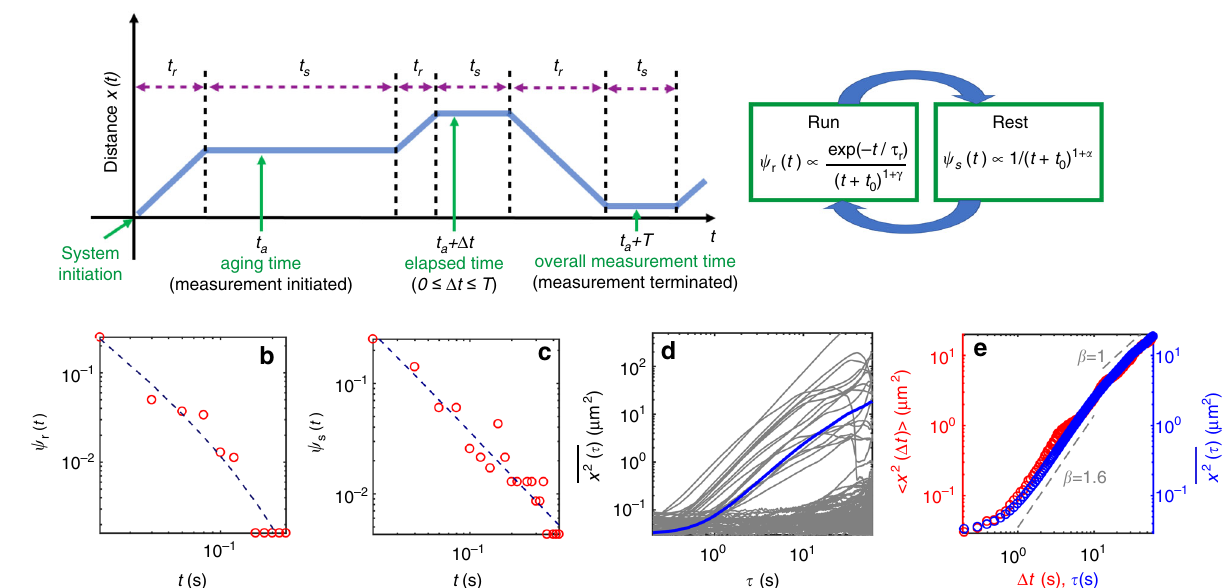
Fig. 2 Stochastic transport dynamics of individual mRNP particles. a A simpli fi ed diagram describing an individual mRNP motion. Run and rest phases are repeated with randomly given sojourn times t r and t s for each. The fl ow diagram shows the distribution of the sojourn times. The direction of run is either anterograde or retrograde with equal probability and without memory of the previous run (Supplementary Table 1). The time t = 0 speci fi es the initial moment that an mRNP begins to be transported by motor proteins. In the experiment, the mRNP motion is observed from an arbitrary time t a (aging time) and for the overall observation time T . b Experimental data of the run time pdf ψ r ( t ). The dashed line represents the best fi t to the data with Eq. 1. c Experimental data of the rest time pdf ψ s ( t ). The rest times follow a power-law distribution (dashed line). d TA MSD curves x 2 ð τ Þ ¼